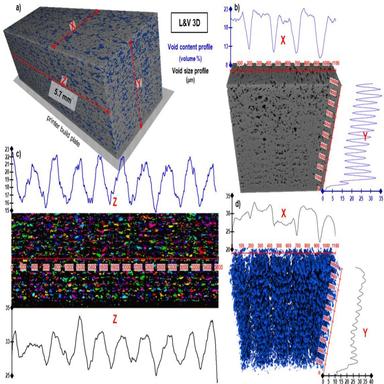
L&V printed a) 3D visualisation of the sample's tomogram image showing X, Y, and Z-axis direction and, in blue, segmented voids; b) void content profiles for X and Y directions plotted against respective image slices scale bar and 3D visualisation of a subset segmented image showing fibres and resin (grey) with voids set 100 % transparent; c) void content and size profiles along the sample printing direction (Z) plotted against longitudinal image slices scale bar and central 2D Label image showing individua